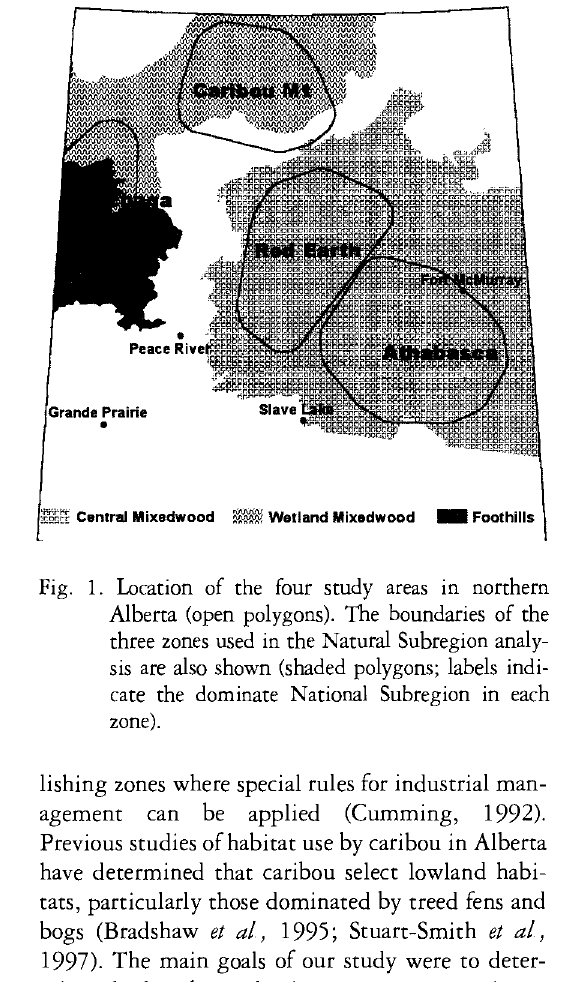
Table 1. Number of caribou tracked with VHF radio- collars, by study